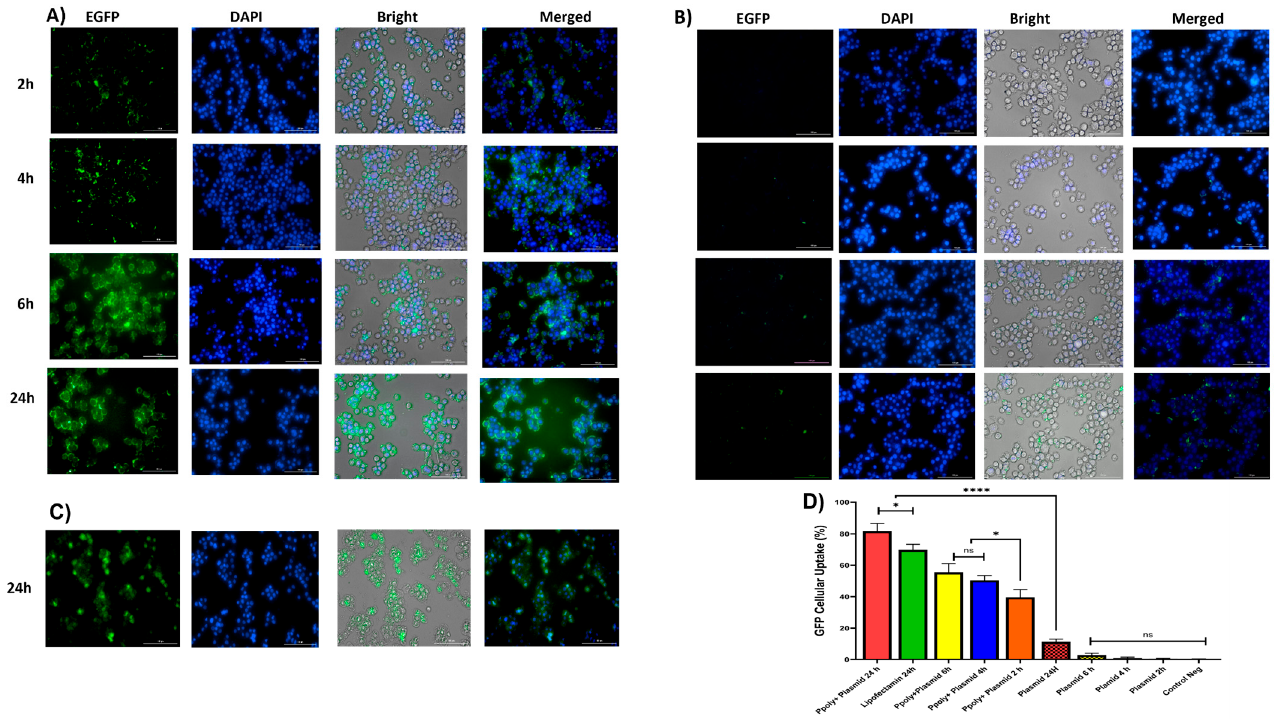
Figure 6. ( A ) Microscopic fluorescent images of 2D cells after 2, 4, 6, and 24 h incubation with PPoly–pEGFP nanocomplexes at an N/P ratio of 25:1. ( B ) Microscopic fluorescent images of 2D cells transfected with free pDNA after 2, 4, 6, and 24 h. ( C ) Microscopic fluorescent images of 2D cells transfected with lipofectamin/pEGFP at a ratio of 3:1 after 24 h. ( D ) Quantitative transfection efficacy (%) determined by the EGFP content as assessed by FACS analysis of treated 2D cells with PPoly–pEGFP nanocomplexes at an N/P ratio of 25:1 compared with free pDNA after 2, 4, 6, and 24 h and lipofectamine after 24 h incubation. Representative measurements of three independent experiments are reported. * p < 0.05 and **** p < 0.001.